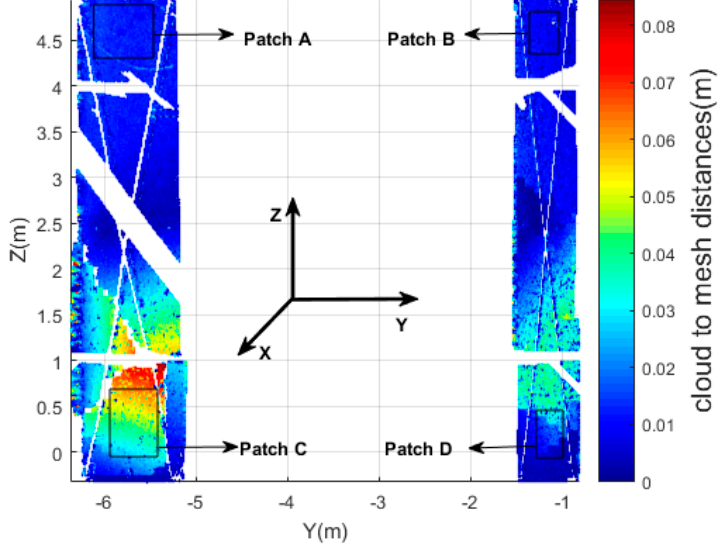
Figure 19. Scatter diagram of the cloud-to-cloud distances (entire wall).